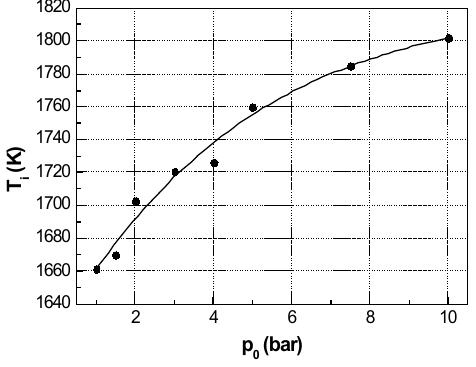
Figure 12. The ignition temperatures in the stoichiometric ethane- air flames at various initial pressures and T